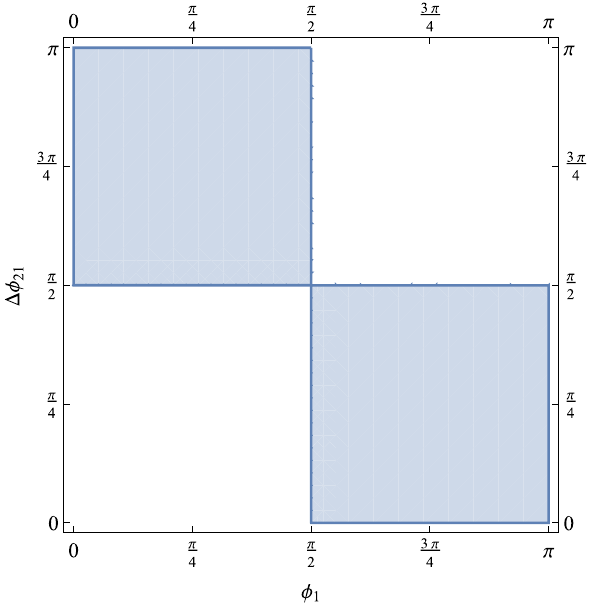
Fig. 4 The left hand side of the Eq. (98) where we see that the right- handed neutrinos can have opposite CP charge (upper left square) or the same (lower right square), which would yield interesting phenomeno- logical implications. See main